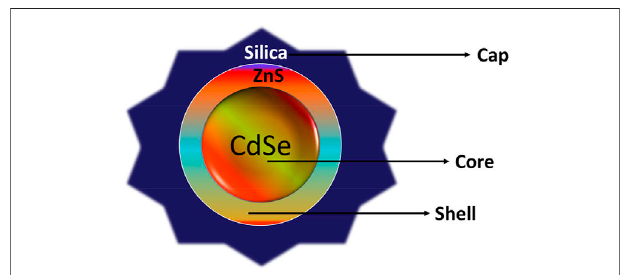
FIGURE 6 | Schematic illustration of quantum